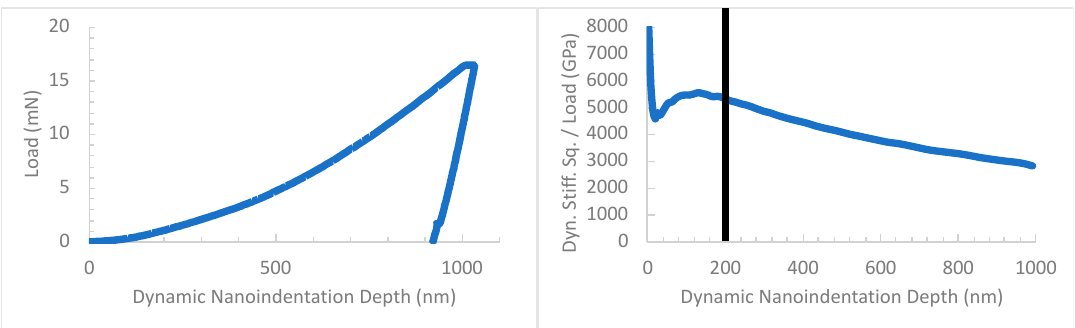
Figure 3. One particles load versus indentation depth curve for continuous stiffness measurement (CSM) nanoindentation of gas-atomized Al 6061 powder with the D 50 provided in Table 1 from Company B when the iMicro Pro system was employed ( Left ). The dynamic sti ff ness squared per load versus indentation depth curve is presented for a set of multiple microparticles (including the particle associate with the load vs. depth plot in ( Left )) embedded within a compliant matrix and subjected to indentation loading as well ( Right ). The imposed line at 200 nm on the plot ( Right ) indicates a potential influence upon the recorded properties by the compliant mounting material relative to the powder. Notice that the prospective limit at 200 to 250 nm is less than the 380 nm upper bound that follows from the Yan et al. model.